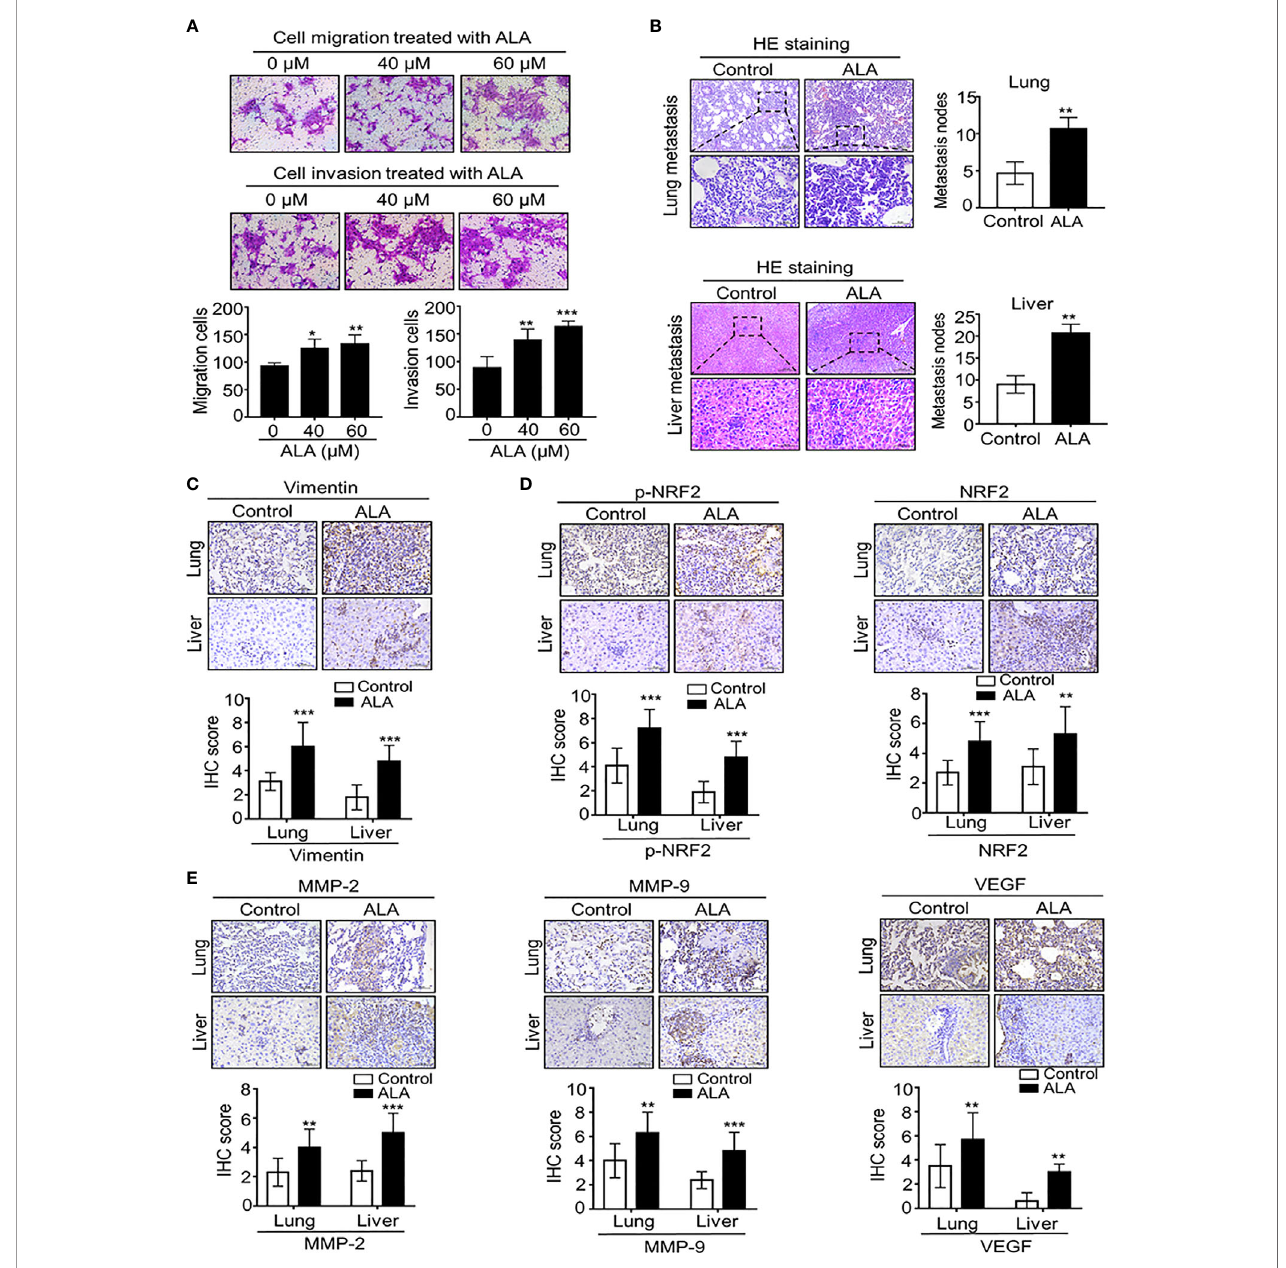
FIGURE 5 | Pharmaceutical NRF2 activation promotes BC metastasis in vitro and in vitro. (A) NRF2 activator ALA promotes BC cell migration and cell invasion. 4T1 cells were subject to cell migration and cell invasion assay upon ALA treatment. Migration or invasion cells were counted in 5 to 10 random fi elds. (B, C) ALA accelerates BC lung and liver metastasis in vivo . 1.0 × 10 5 4T1 cells in 100 m l PBS buffer were injected into in the left mammary fat pad of female NOD-SCID mice. Post-injection 3 to 5 days, experimental mice were peritoneally injected (i.p.) with or without ALA (80mg/kg) three times per week as described in M&M. After the indicated time point, lungs and livers were collected and metastatic nodes were counted by H&E staining (B) . Micro-metastasis marker vimentin was detected by IHC staining (C) . (D) ALA induces NRF2 activation in vivo. 4T1-bearing mice were treated with ALA as above mentioned and p-NRF2 and NRF2 were detected by IHC staining in metastatic lung and liver tissues. (E) ALA enhances metastasis-associated gene expression in vivo . 4T1-bearing mice were treated with ALA as above mentioned and metastasis-associated proteins MMP-9, MMP-2 and VEGF were detected by IHC staining in lung and liver metastatic nodes. Data are presented as mean ± SD of three independent experiments. Scale bar: 50 m m. Representative images are shown. *p < 0.05, **p < 0.01 and ***p < 0.001 between the indicated groups determined by unpaired Student ’ s t -test or the one-way analysis of variance